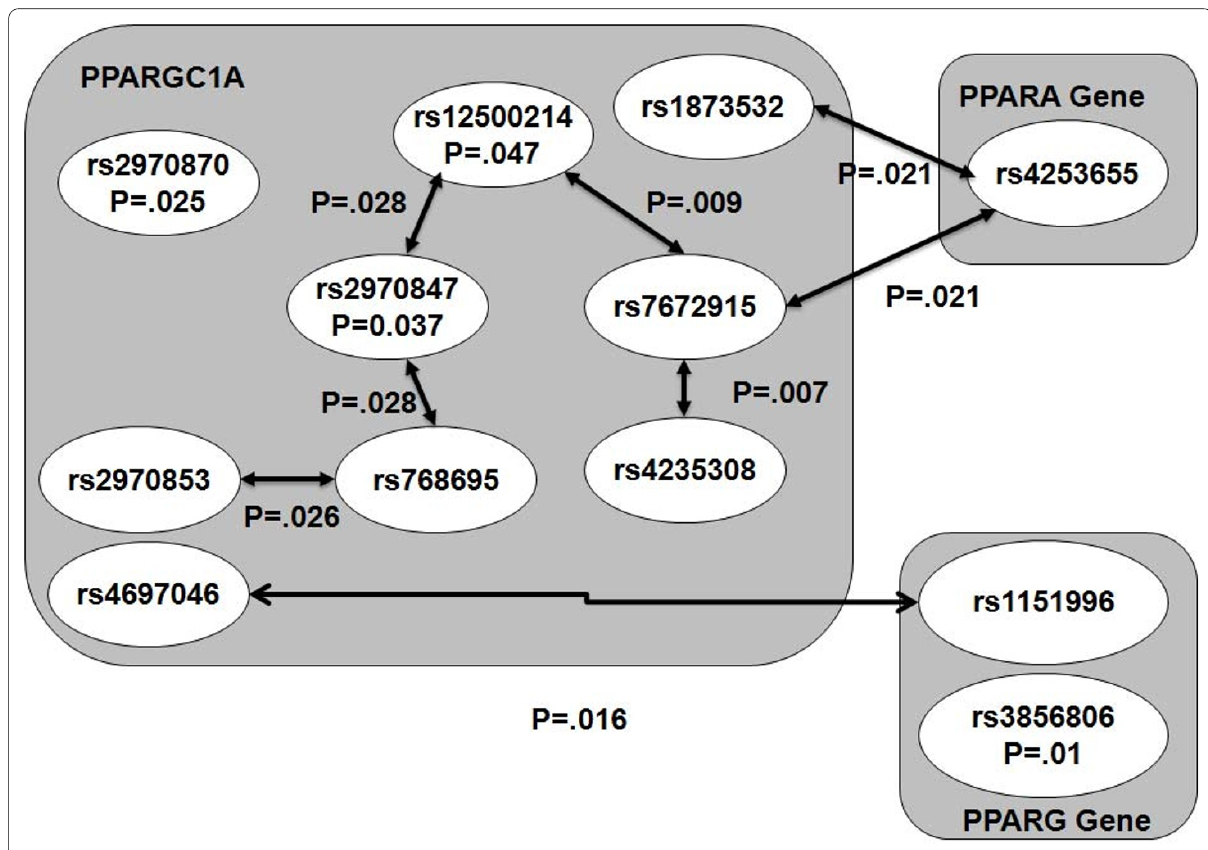
Figure 2 Significant SNPs and their interactions (within-gene and gene-gene), with corresponding p-values identified by the two-step ridge regression analysis are shown . SNPs are grouped by the candidate genes (i.e., PPARGC1A , PPARA and PPARG ); significant interactions are shown by bidirectional arrows between two interacting SNPs: within-gene (arrows within boxes) and gene-gene interactions (arrows between